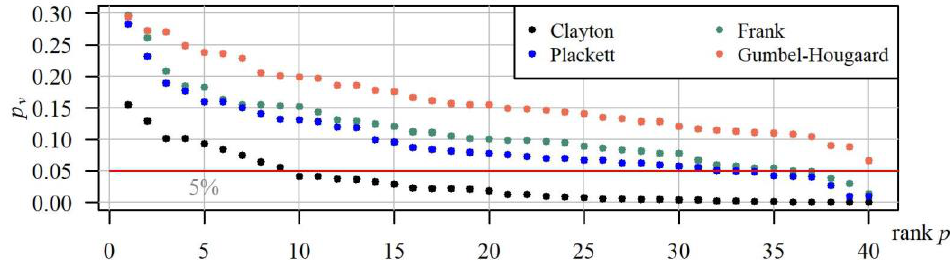
Figure 11. Distribution of descending p v -values of the Anderson – Darling goodness-of-fit test for distributions of the variable T g max , V g max based on copulas: Clayton, Frank, Gumbel–Hougaard and Plackett, in 40 gauging cross-sections.